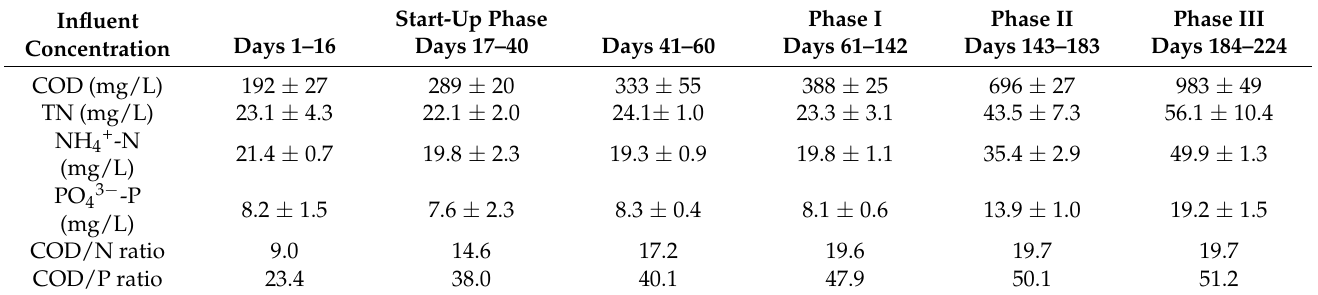
Table 1. Main components of synthetic pre-fermented high-strength